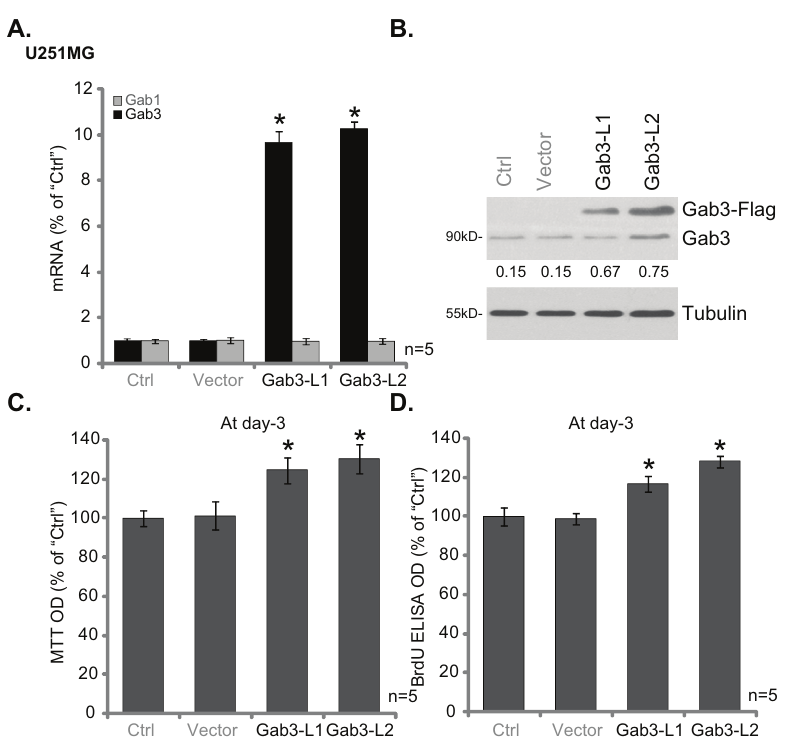
Fig 4. Forced overexpression of Gab3 promotes U251MG glioma cell proliferation. Stable U251MG gliomacells, expressingwt-Gab3 (two lines, “Gab3-L1/L2”) or empty vector (“Vector”, pSuper-puro), as well as the parentalcontrol (“Ctrl”) cells, were subjectedto qRT-PCR assay (A) and Western blotting assay (B) of listed genes; Cell proliferation was tested by MTT assay (C) and BrdU ELISA assay (D). Relativeexpression of Gab3 was quantified ( vs . Tubulin, B). For all these assays, the exact same number of cells of different treatment were initiallyplated into each well/dish.Data were presented as mean ± SD. * p < 0.05 vs . “Ctrl”